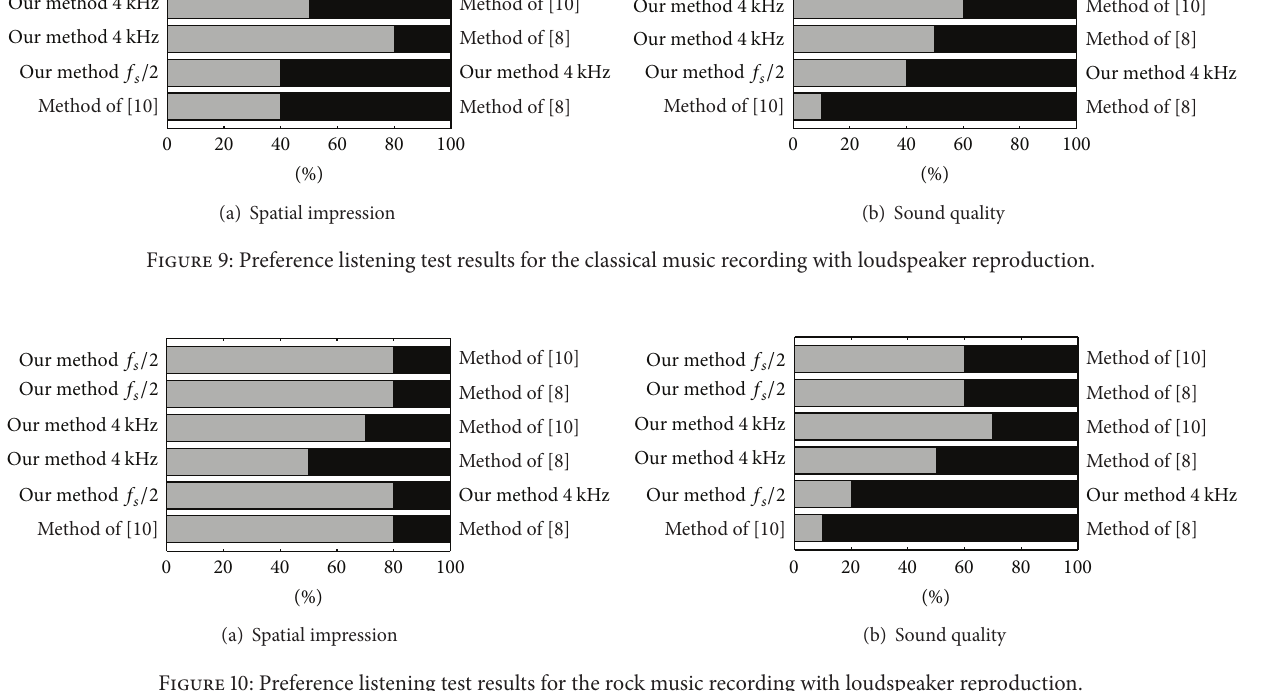
Figure 10: Preference listening test results for the rock music recording with loudspeaker reproduction.